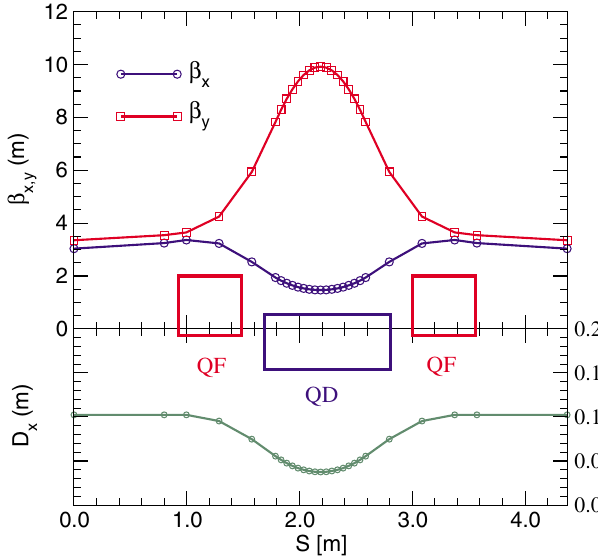
FIG. 2. (Color) Betatron functions and dispersion in the basic cell at the central